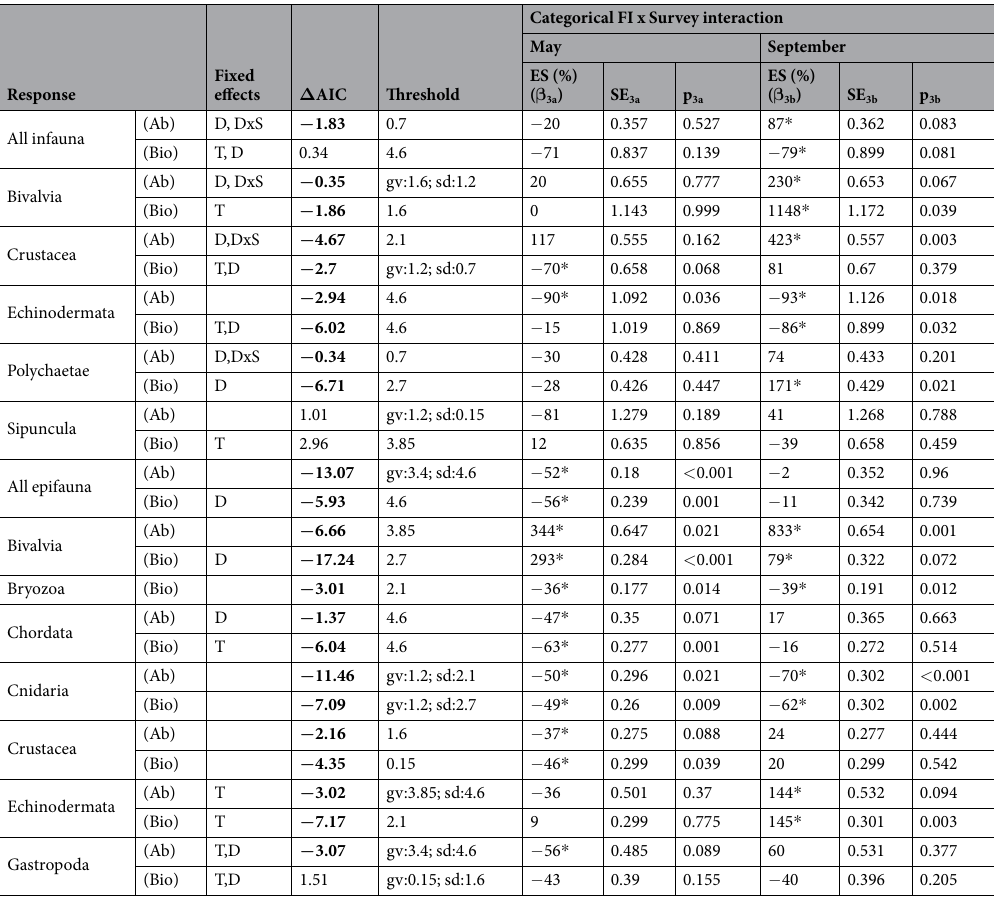
Table 3. Results of the GLMMs for the BACI experiment on infaunal and epifaunal abundance and biomass at the population and class or phylum level for categorized fishing intensity (FI), i.e. threshold analysis. Threshold is the FI that split low FI from high FI. β 3a and β 3b are the estimates of the ‘S x FI’ interaction as in eq. 1 for before to after and before to four months after fishing respectively, with corresponding standard errors (SE) and p-values (p). β s are expressed as percentage change, i.e. effect size (ES) (See caption Table 2). Here, ES is the percentage change at the FI threshold. P. maximus and O. fragilis were excluded from the epifaunal